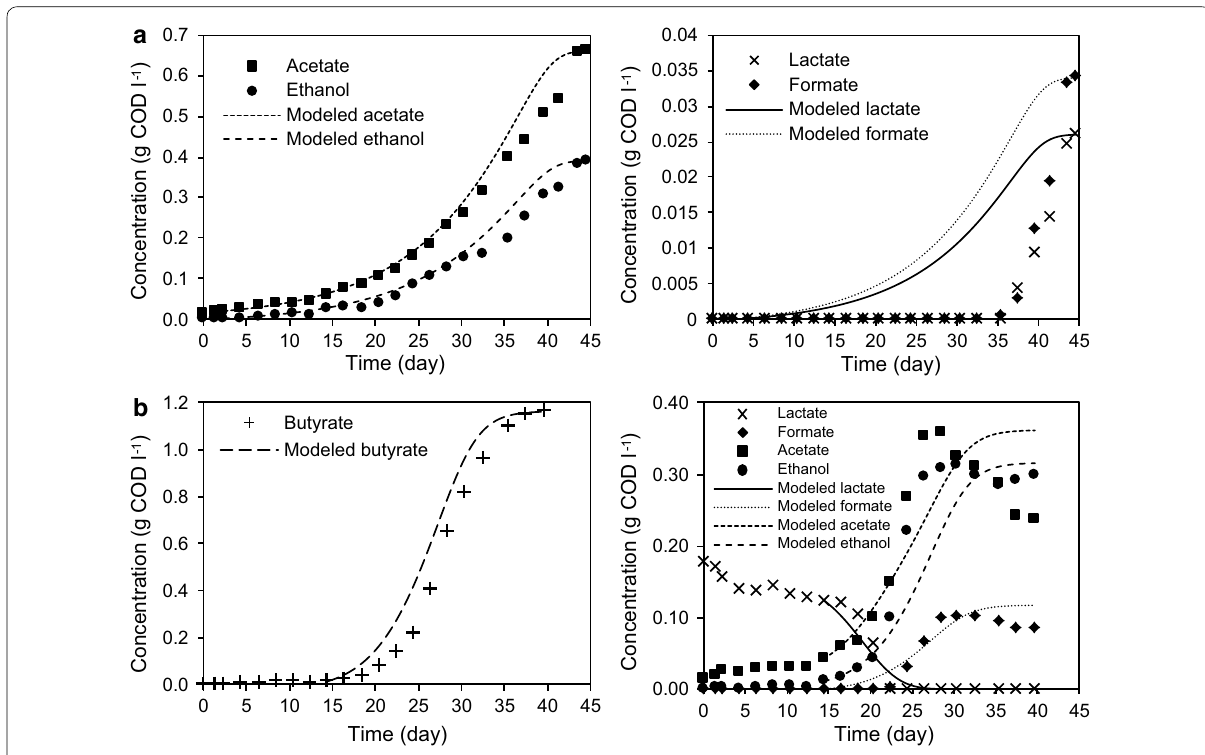
Fig. 4 Experimental and modeled profile of metabolites in a mono‑culture and b